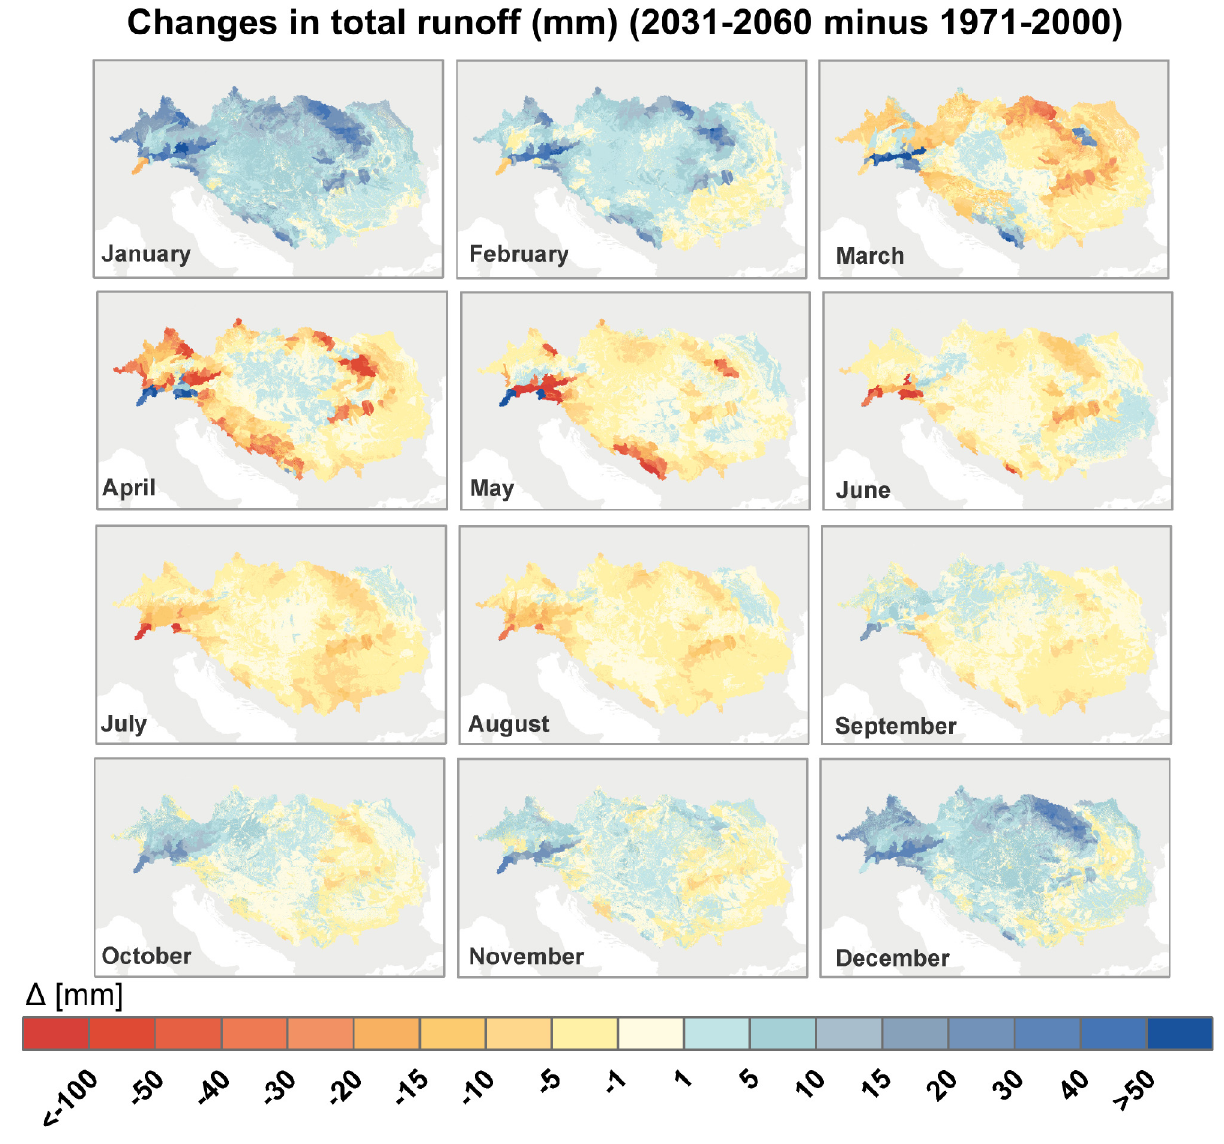
Figure 9. Changes in total runoff (mm/month) as the multi-model mean